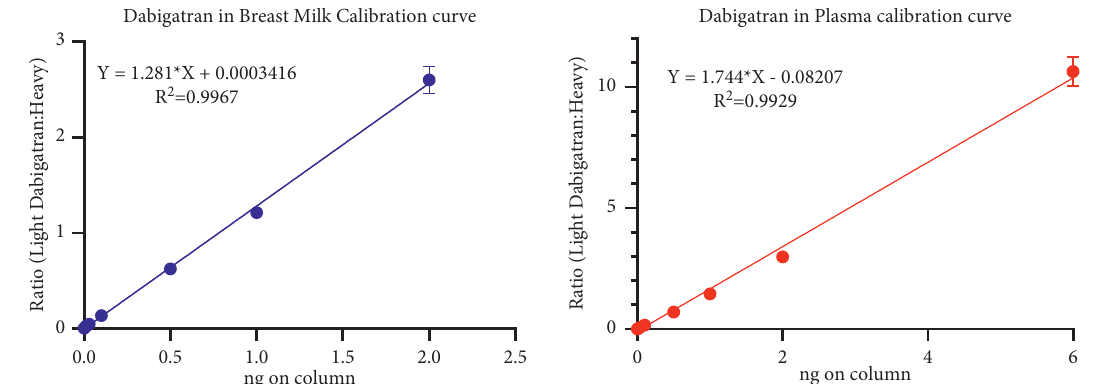
Figure 3: Extracted ion chromatograms of blank plasma (a), blank breast milk (b), plasma spiked with 13 C spiked with 13 C 6 -dabigatran (d), plasma spiked with 13 C 6 -dabigatran and dabigatran (e), and breast milk spiked with 13 C 6 -dabigatran and dabigatran (f).